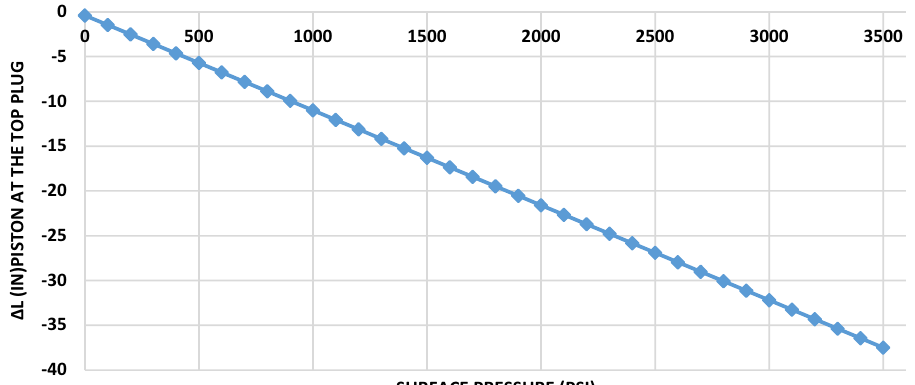
Fig. 3 Elongation of casing due to piston effect at top plug in case of flash